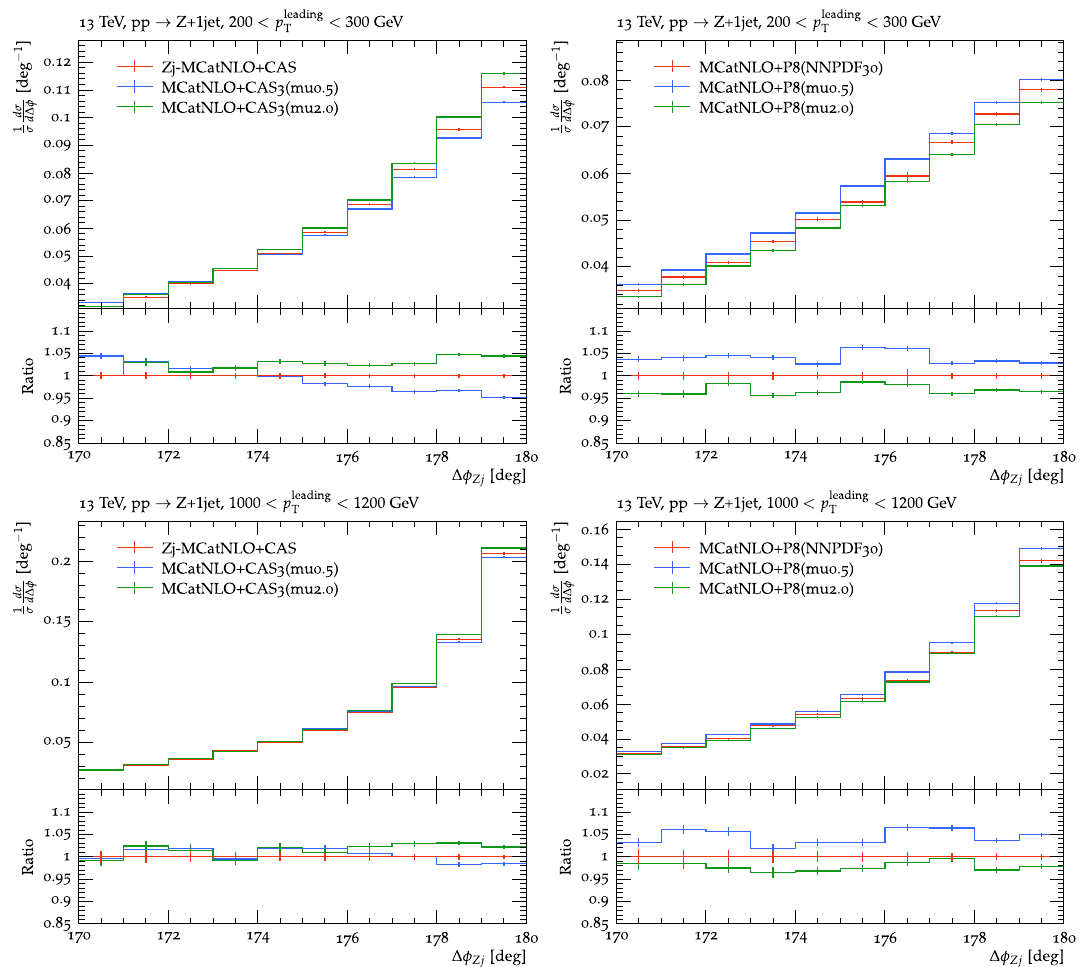
> 1000 GeV (lower row). The pre- 200 GeV (upper row) and p leading T dictions with different matching scales μ m varied by a factor of two up and down are > T